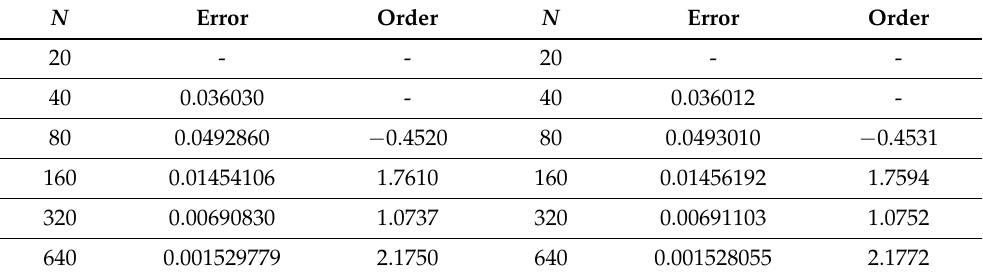
Table 2. Accuracy test of the m system (8) and (9): we show the L 2 -norm of the relative error for | m | , with the parameters defined in T EST A (left) and T EST C (right).